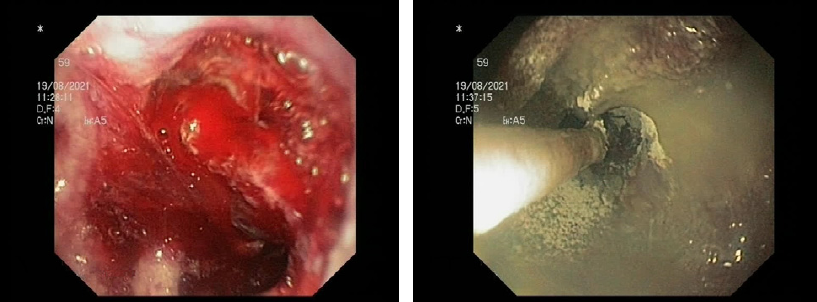
Figure 1. Duodenal Figure 1. Duodenal cancer.